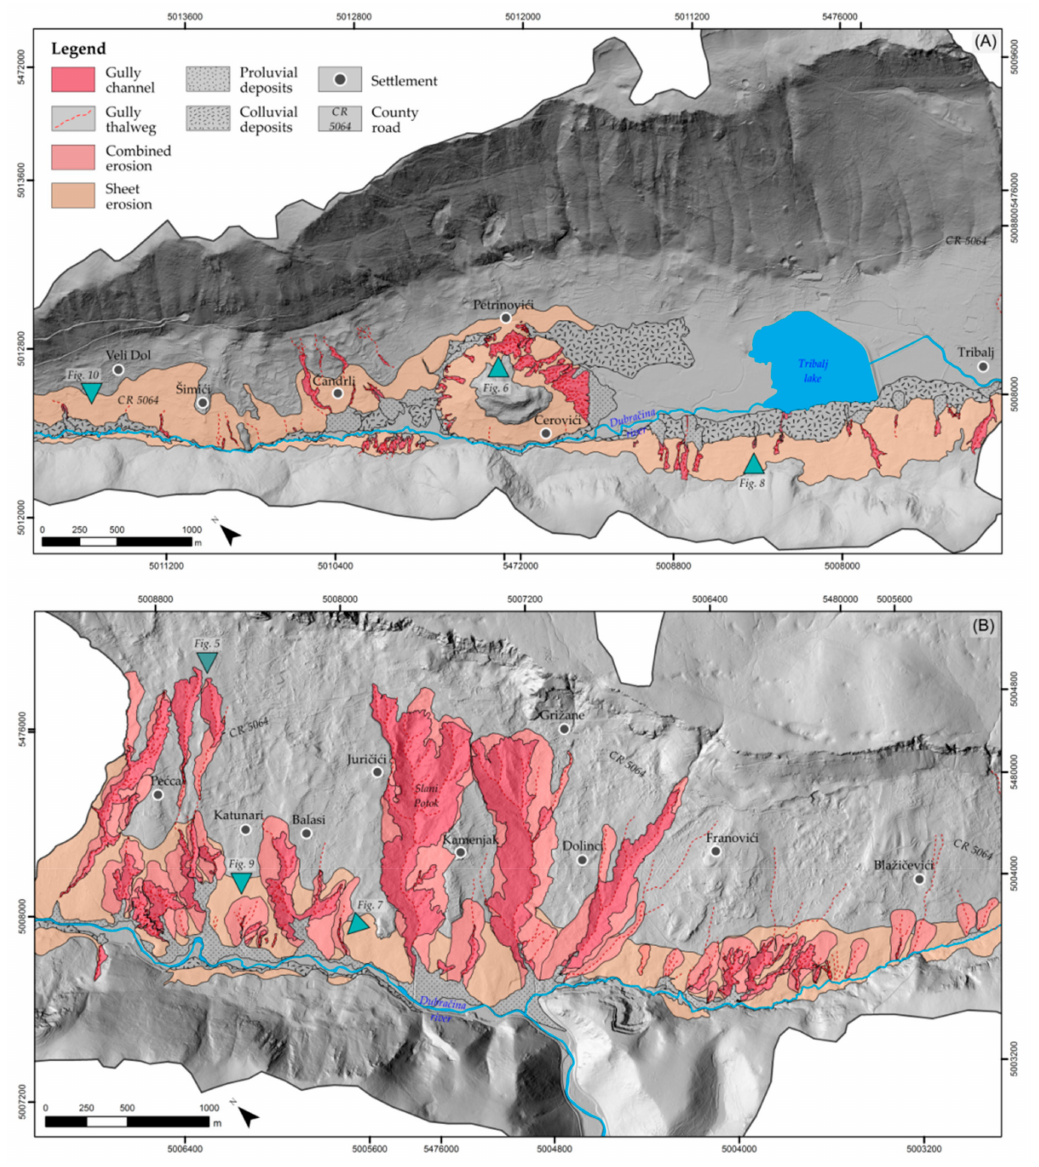
Figure 11. Details from the erosion inventory map of the Vinodol Valley for ( A ) the northwestern part and ( B ) the central part of the valley. Green marks highlight examples of erosion phenomena presented in previous